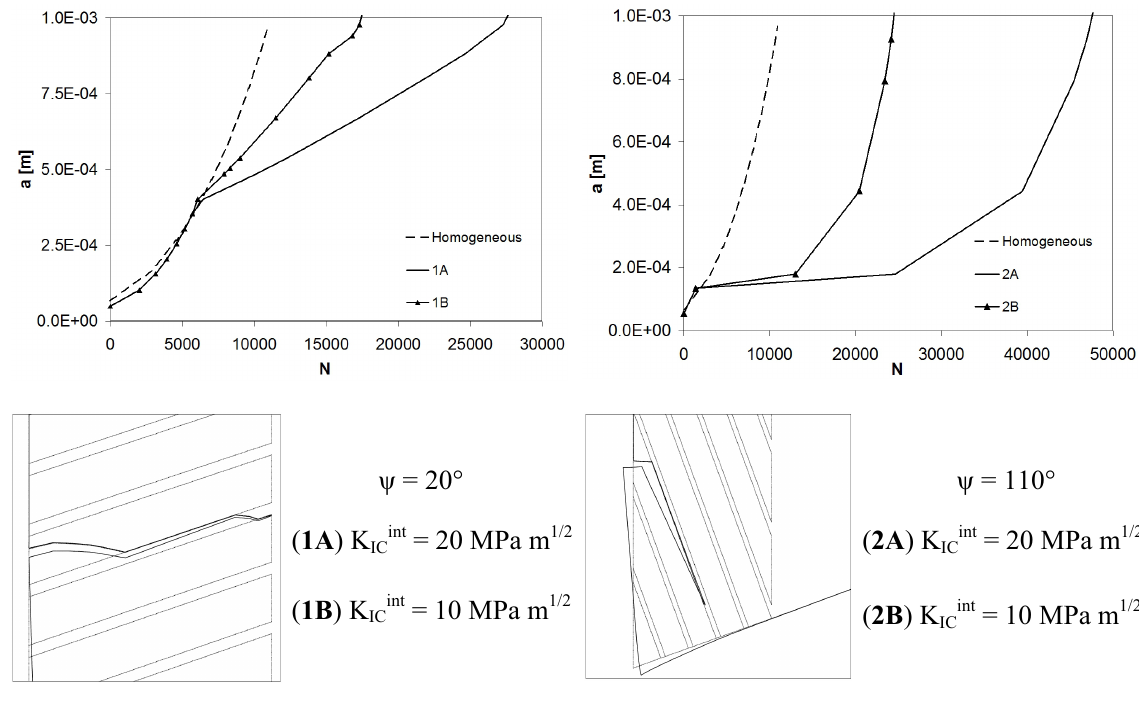
Figure 10. The effects of rods’ inclination and interface fracture toughness on fatigue